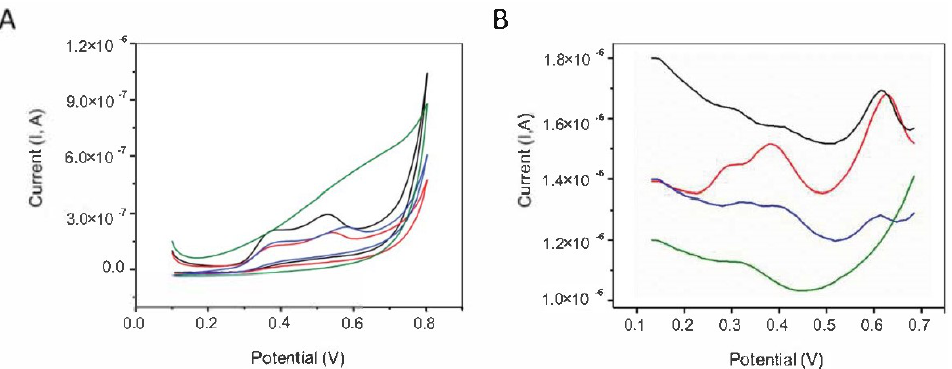
Figure 3. ( A ) Cyclic Voltammetry (CV) and ( B ) Differential Pulse Voltammetry (DP) of formulations: I (black line), II (red line), III (blue line), and IV (green line) in ethanol (0.1 M phosphate buffer of pH 7 (1/1 v/v )) at glassy carbon electrode (GCE). Scan rate 50 mV/s.